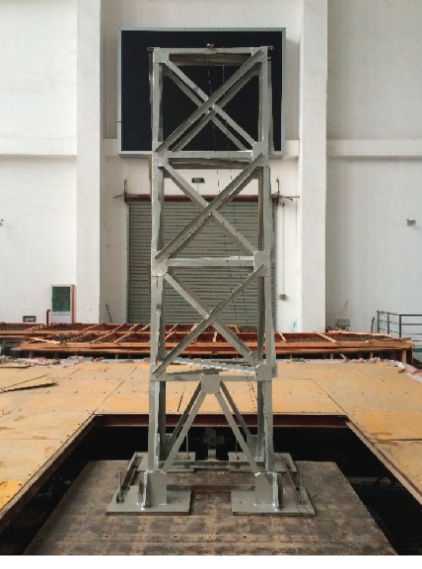
Figure 6: Equivalent generation tower